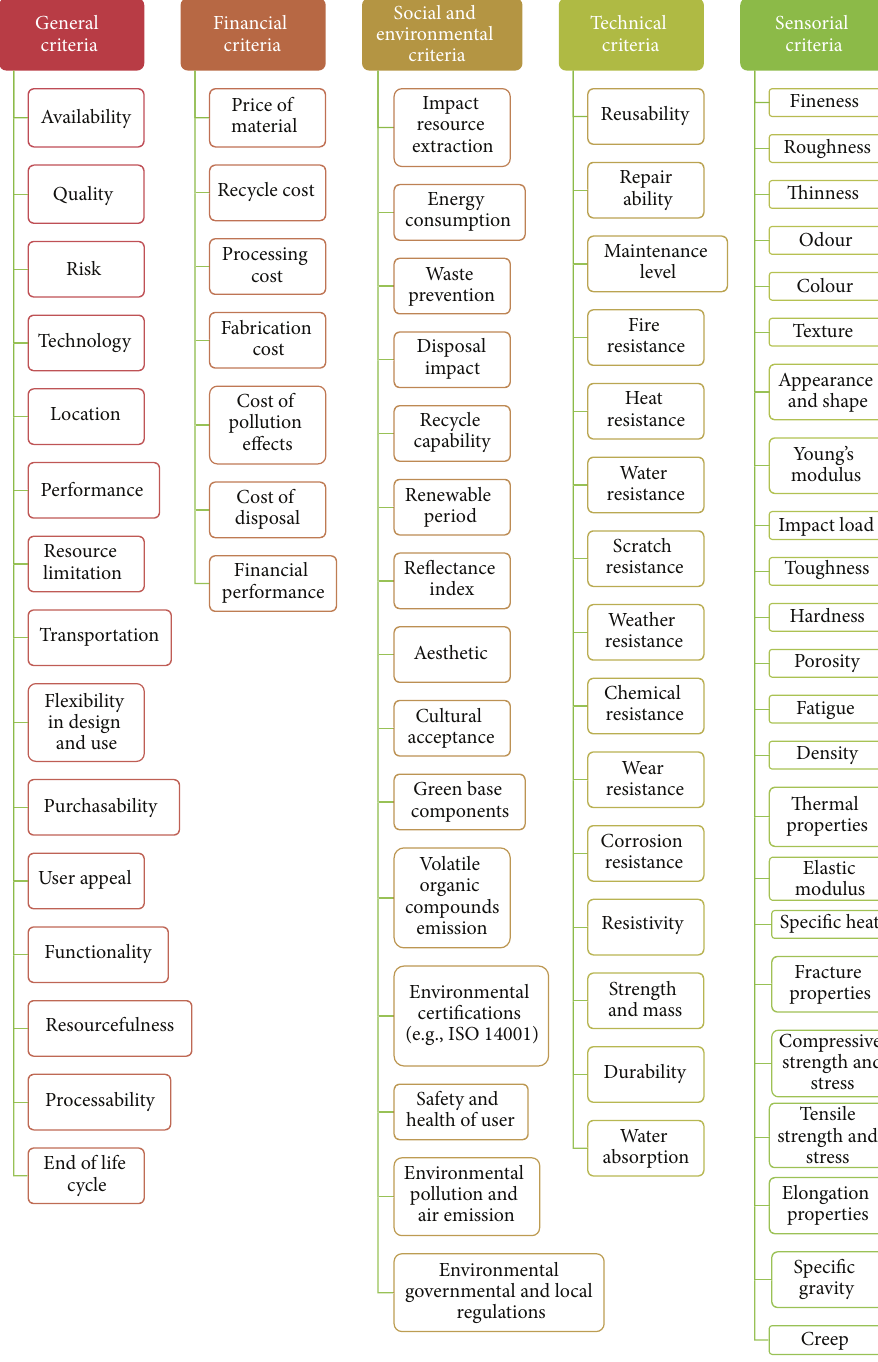
Figure 4: Main influencing subcriteria in material